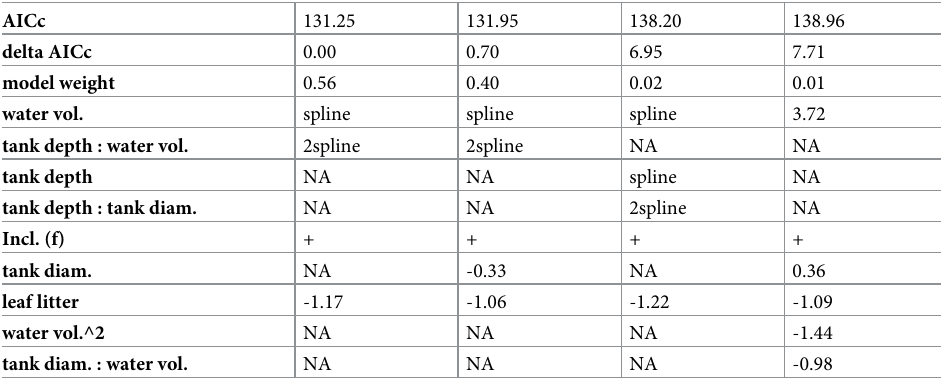
Table 2. AICc table for all models with delta AICc < 10. Vol = volume; diam = diameter; incl = inclination (factor); spline = non-linear cubic spline fitted; 2spline = interacting cubic splines fitted to both terms. In parametric models, standardized coefficients rounded to 2 decimal places are shown. NA means not included in the model. “+” indicates that the term was modelled with a smoother. See S3 Table for all